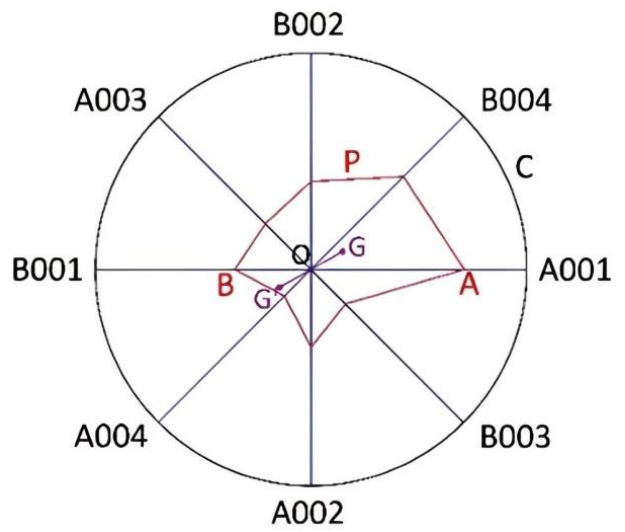
Figure 3. Components of the balance-based conceptual model. O: Center of the circle; C: the circle for the balance indicator; A & B: scores of dichotomies for each indicator; OA & OB: line segments equal to the scores; P: balance indicator curve; G: balance indicator curve geometric center (centroid); OG: the deviation of the centroid from the center of circle; G’: the diametrical point of G with respect to O.